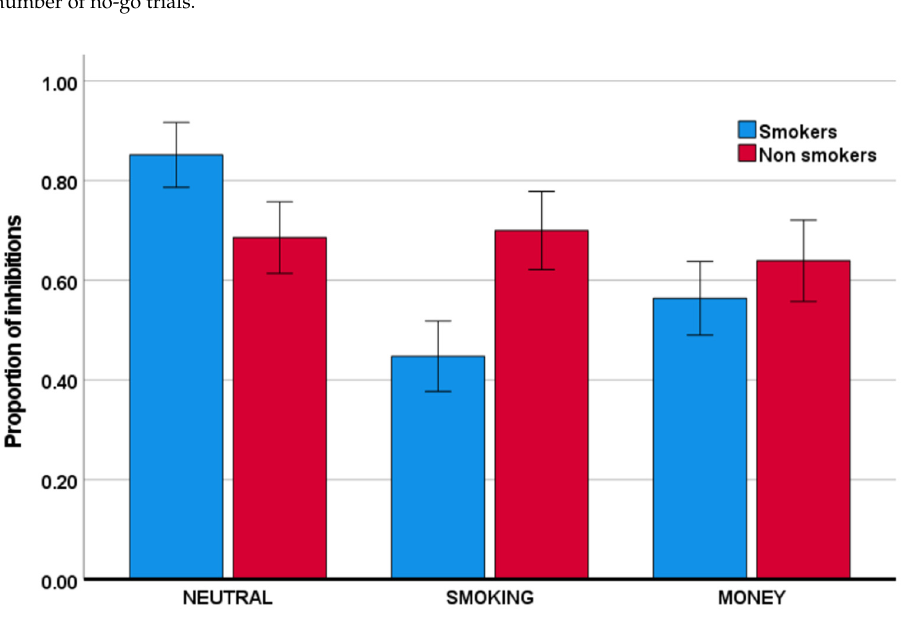
Figure 2. Mean proportion of inhibitions (the number of successful non-responses to no-go stimuli divided by the total number of no-go trials) for the smoker and nonsmoker groups across the neutral, smoking, and money conditions. Error bars indicate +/ − 2 standard errors from the mean.